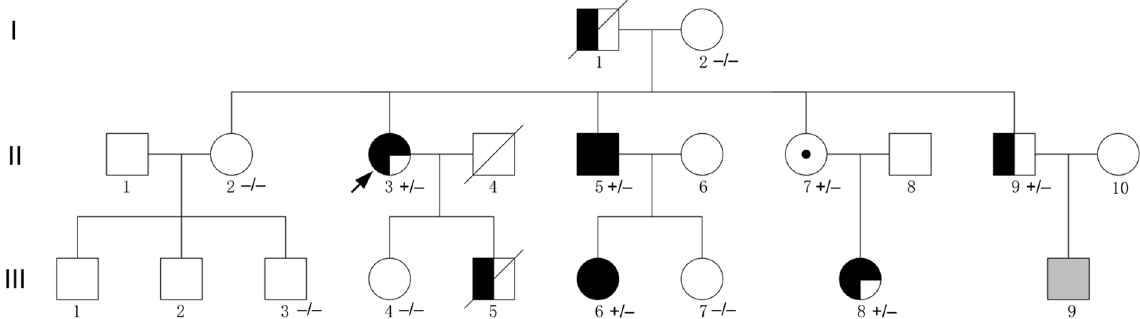
Figure 1. Pedigree of the family with PRKAG2 syndrome. Squares indicate males and circles indicate females. Filled symbols indicate the disease phenotype in affected individuals, i.e., cardiac hypertrophy (left half filled), ventricular pre-excitation (right-upper quadrant filled), or conduction system disease (right-lower quadrant filled). Open symbols represent unaffected individuals, symbols with dots represent mutation carriers without clinical manifestation, shading represents an uncertain clinical status and no sample was available. An arrow denotes the indexed subject and slants denote dead individuals. + indicates PRKAG2 p.V336L mutation positive, and − indicates PRKAG2 p.V336L mutation